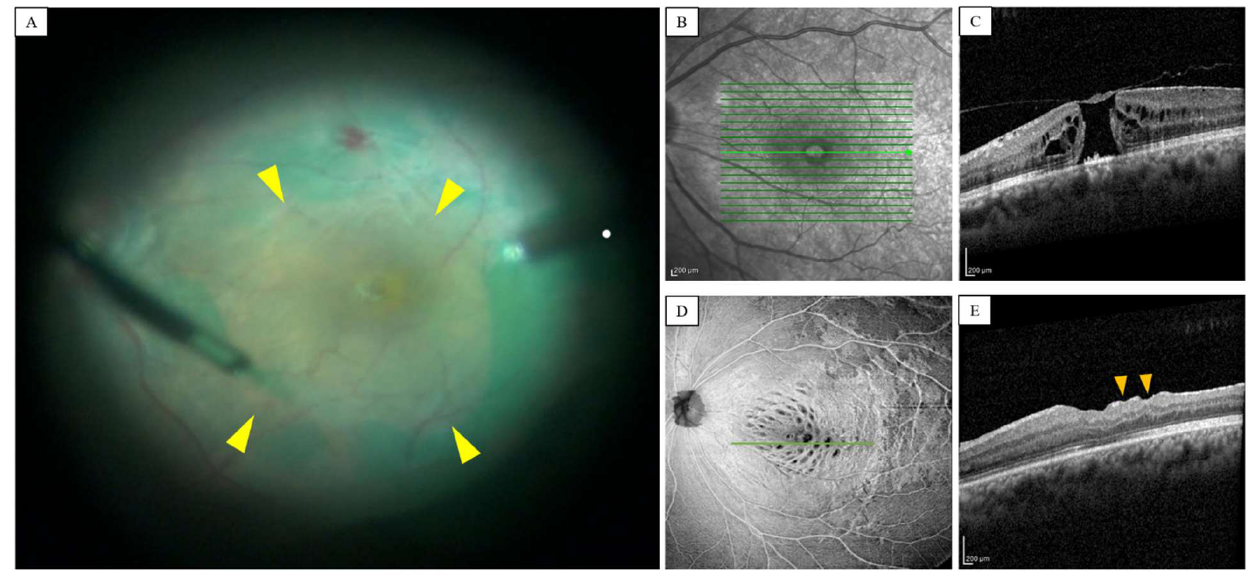
Figure 1. Left eye of a 61-year-old man treated with vitrectomy and ILM peeling for IMH. ( A ). The ILM around the macular hole was removed using pinch-and-peel technique after indocyanine green staining. The yellow arrows represent the extent of the inner limiting membrane peeling. A full-thickness macular hole was observed in fundus image ( B ) and OCT B-scan ( C ) before the surgery. The green line with the arrow in ( B ) indicates the scan line for the B-scan OCT images in ( C ). En face OCT images ( D ) at four-month postoperatively showed a clear CMDS appearance (i.e., concentric dark spots) inside the ILM peeling area. And some focal dimples corresponding to dark spots on green line in ( D ), were visible in the RNFL on B-scan OCT images in ( E ) (yellow